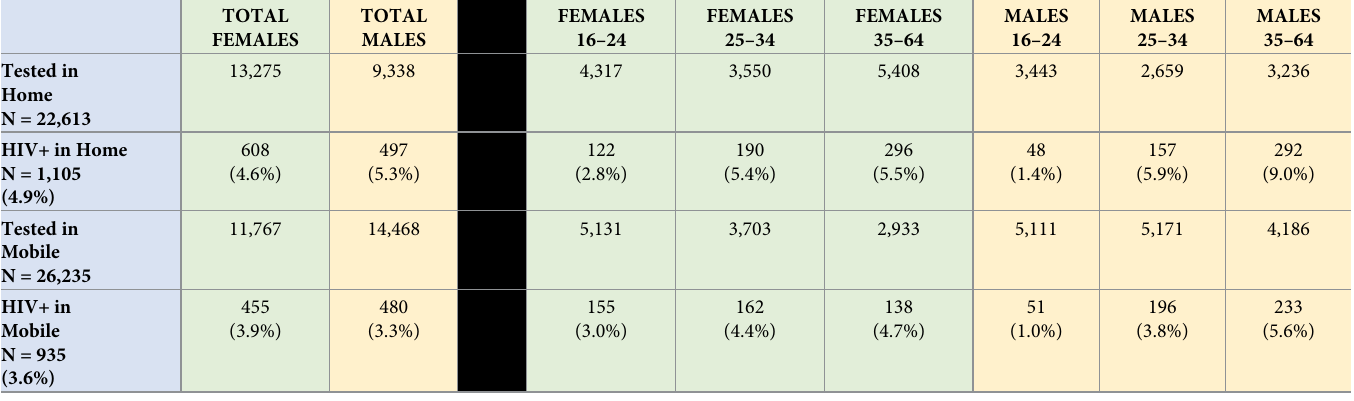
Table 2. Percentage of newly identified HIV-positive persons among all persons tested by sex, age & testing venue. TOTAL FEMALES